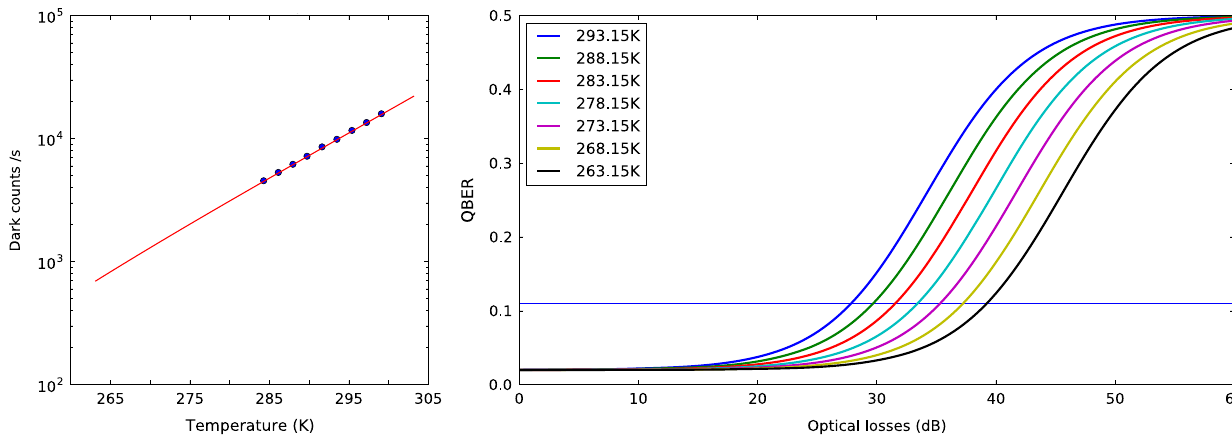
Fig. 6 Impact of noise and losses on an example BBM92 system. Left – dark counts measured in a typical SAP500 GM-APD as a function of temperature. Blue dots are measurements, red line is fi tted exponential, ae ( x − 273.15) b + c where a = 1790, b = 0.08, c = − 81. Right – QBER as a function of optical losses (e.g., diffraction, atmosphere, etc.) and technical noise in the SAP500 detector at different temperatures. Secure QKD is only possible when QBER is below 11% ( dotted line